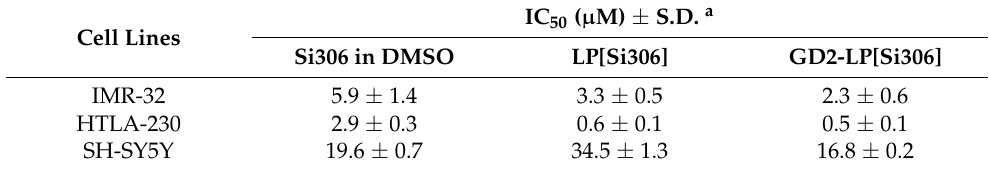
Table 3. IC 50 values of Si306 and liposomal formulations evaluated on NB cells. Cell Lines